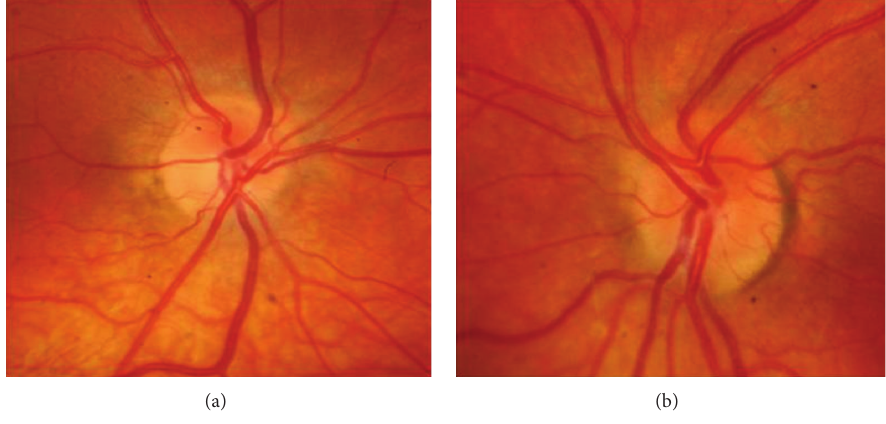
Figure 3: ((a), (b)) Definite right and left optic nerve edema resolution after 8